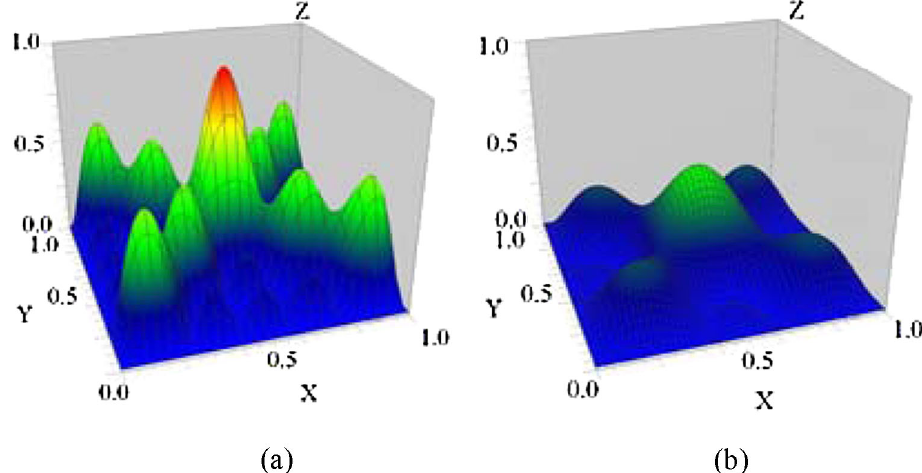
FIG. 3. (Color) (a) Axial E field in a square cavity of side L excited in its first three odd- n TM ffiffiffi p 2 L=c , at the time of transit of a bunch. (b) Same as (a), except at a time 1 = 20 of the bunch period after bunches spaced in time by passage of the bunch. One notes that the peak electric field is now smaller by about a factor of 3, than in Fig.